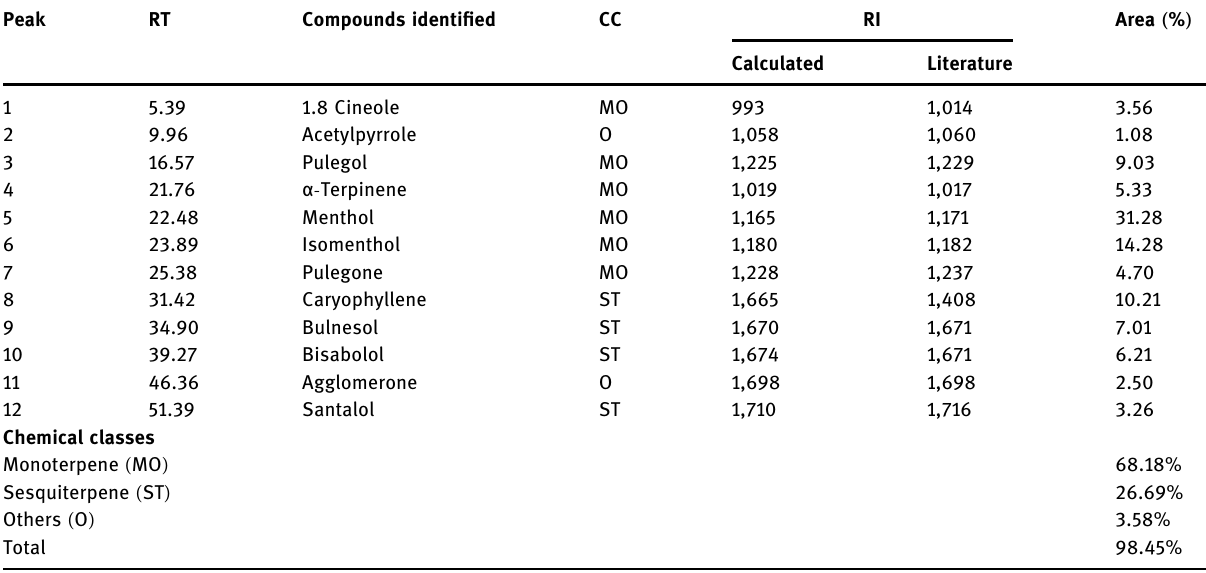
Table 1: Phytochemical compounds of EOR pro fi led by GC - MS